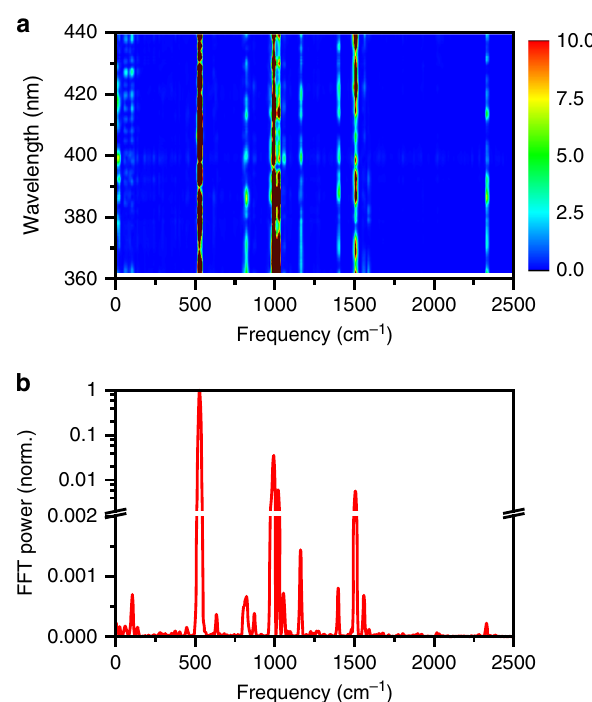
Fig. 4 Fast Fourier transform (FFT) power spectra of photodetached aqueous phenoxide. a 2D FFT power spectrum of photodetached phenoxide in aqueous solution computed over the entire probe spectral range. The color scale gives the FFT power. b Line-out of normalized FFT power spectrum at 406 nm. Note the linear and logarithmic scales before and after the break in the vertical axis. Source data are provided as a Source Data fi